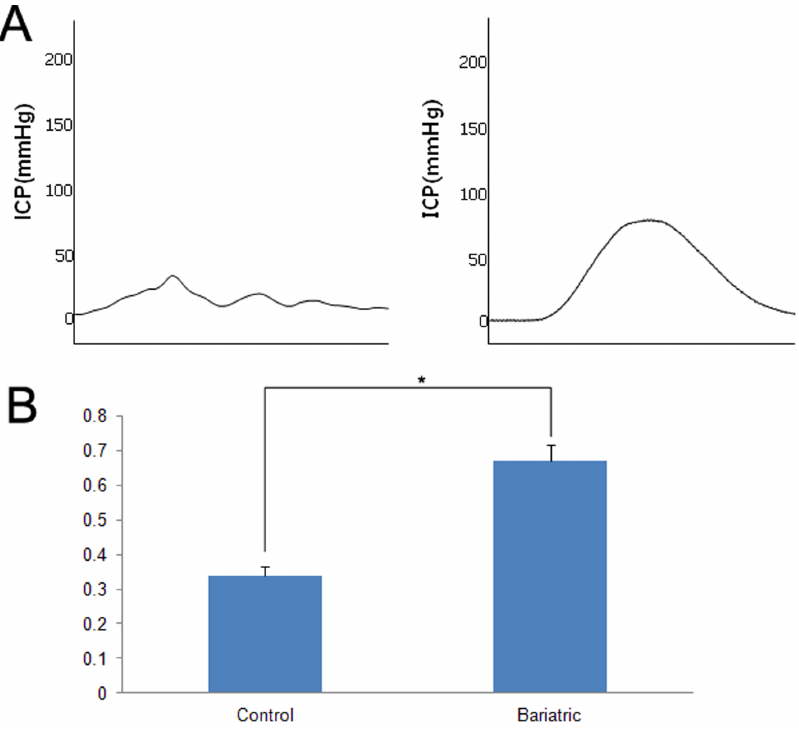
Figure 3. Erectile function result at 4 weeks after surgery. ( A ) Representative recordings of intracavernosal pressure (ICP) for the control and bariatric surgery groups in response to cavernous nerve stimulation at 10 V. ( B ) The ratio of ICP/mean arterial pressure (MAP) was calculated and compared for each group. (*: p=0.021). doi:10.1371/journal.pone.0104042.g003 PLOS ONE |